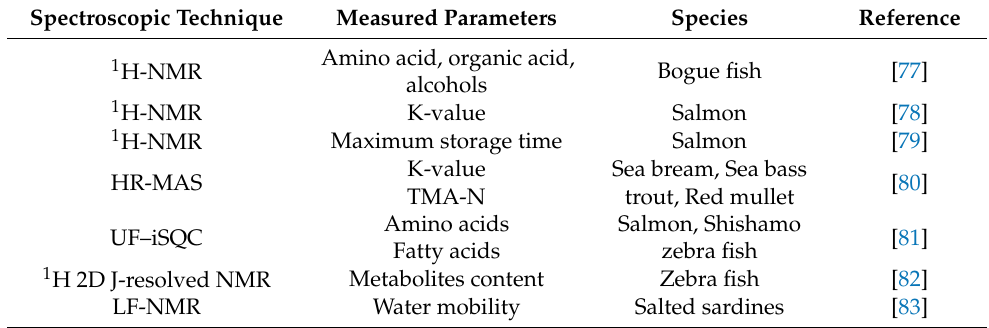
Table 4. Nuclear magnetic resonance